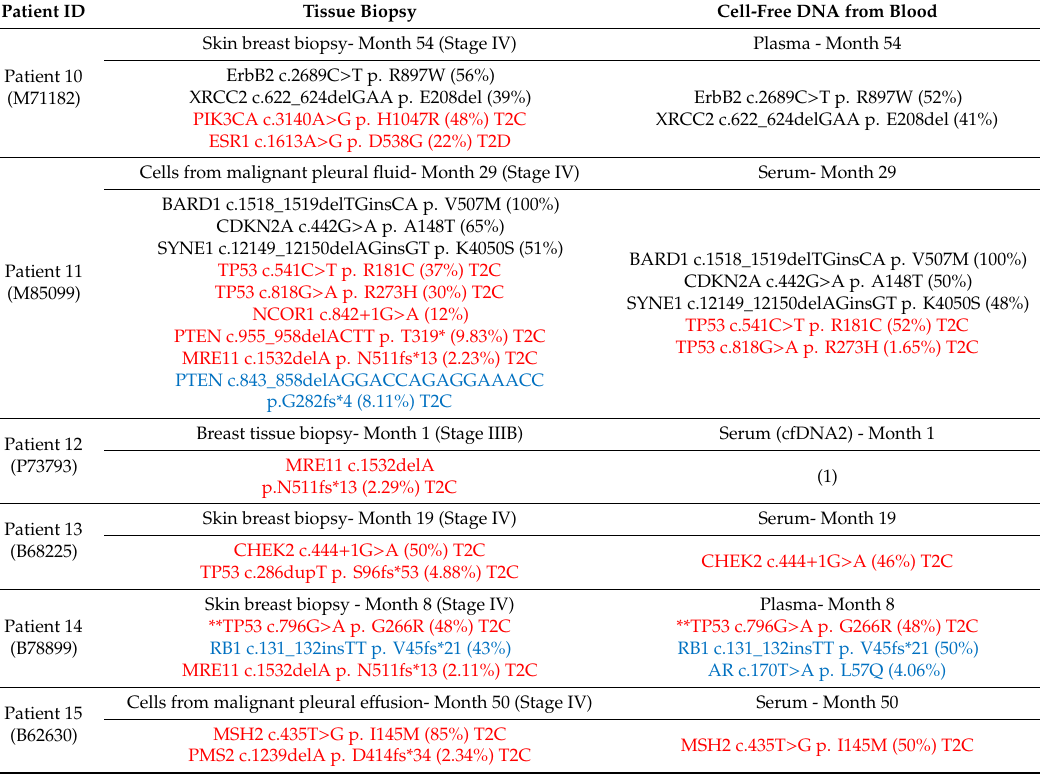
Table 2. Clinically relevant variants in non-triple negative IBC. Variants are classified as pathogenic (in red), likely pathogenic (in blue) or variants of uncertain significance (in black). Variants are also classified according to its actionability: T2C indicates potential clinical significance and FDA-approved therapies for di ff erent tumor types or investigational therapies; T2D variant with potential clinical significance with evidence from preclinical trials or few cases reports without consensus. For each variant, its allele fraction (AF) is indicated in parenthesis. The samples used to study genomic variants, time of collection from disease onset and stage of the disease at the time of sample collection are indicated. (1) variants of clinical significance were not detected. (**) Indicated putative germline variant. All patients, except patient 12, were pre-treated at the time that the samples were collected for the